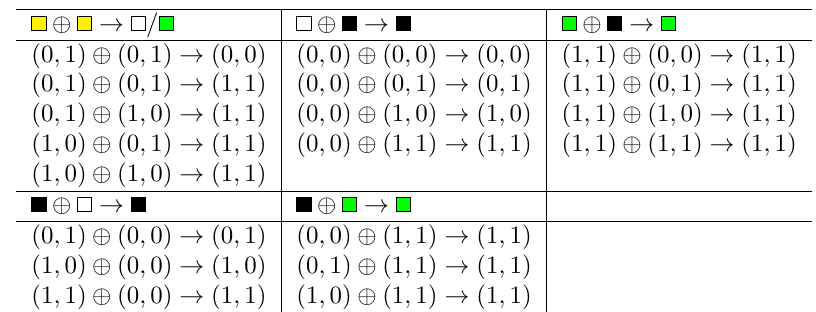
Table 6: Attribute propagation through XOR